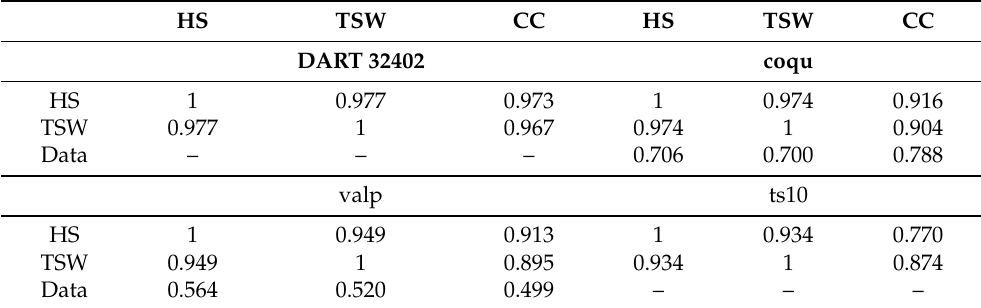
Table 3. Correlation coefficients of the time series in Figure 4 for Experiment 2010. The following abbreviations are used—HS: HySEA; TSW: TsunAWI; CC: COMCOT. Refer to Figure 1 for the tide gauge and DART